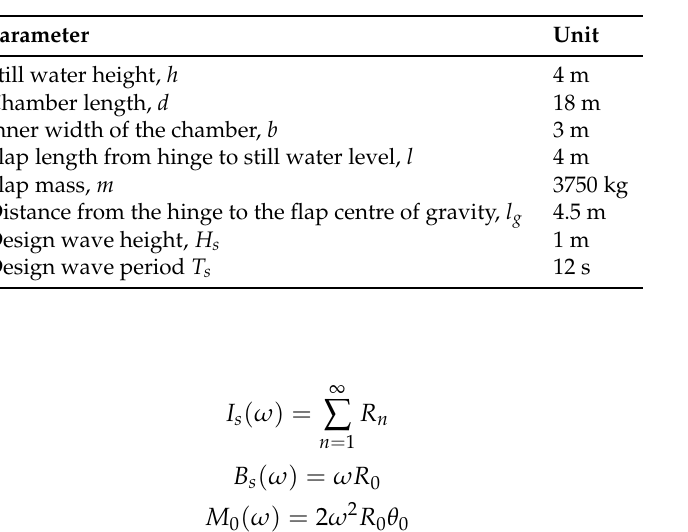
Table 1. Preliminary device parameters of the 50 kW unit.